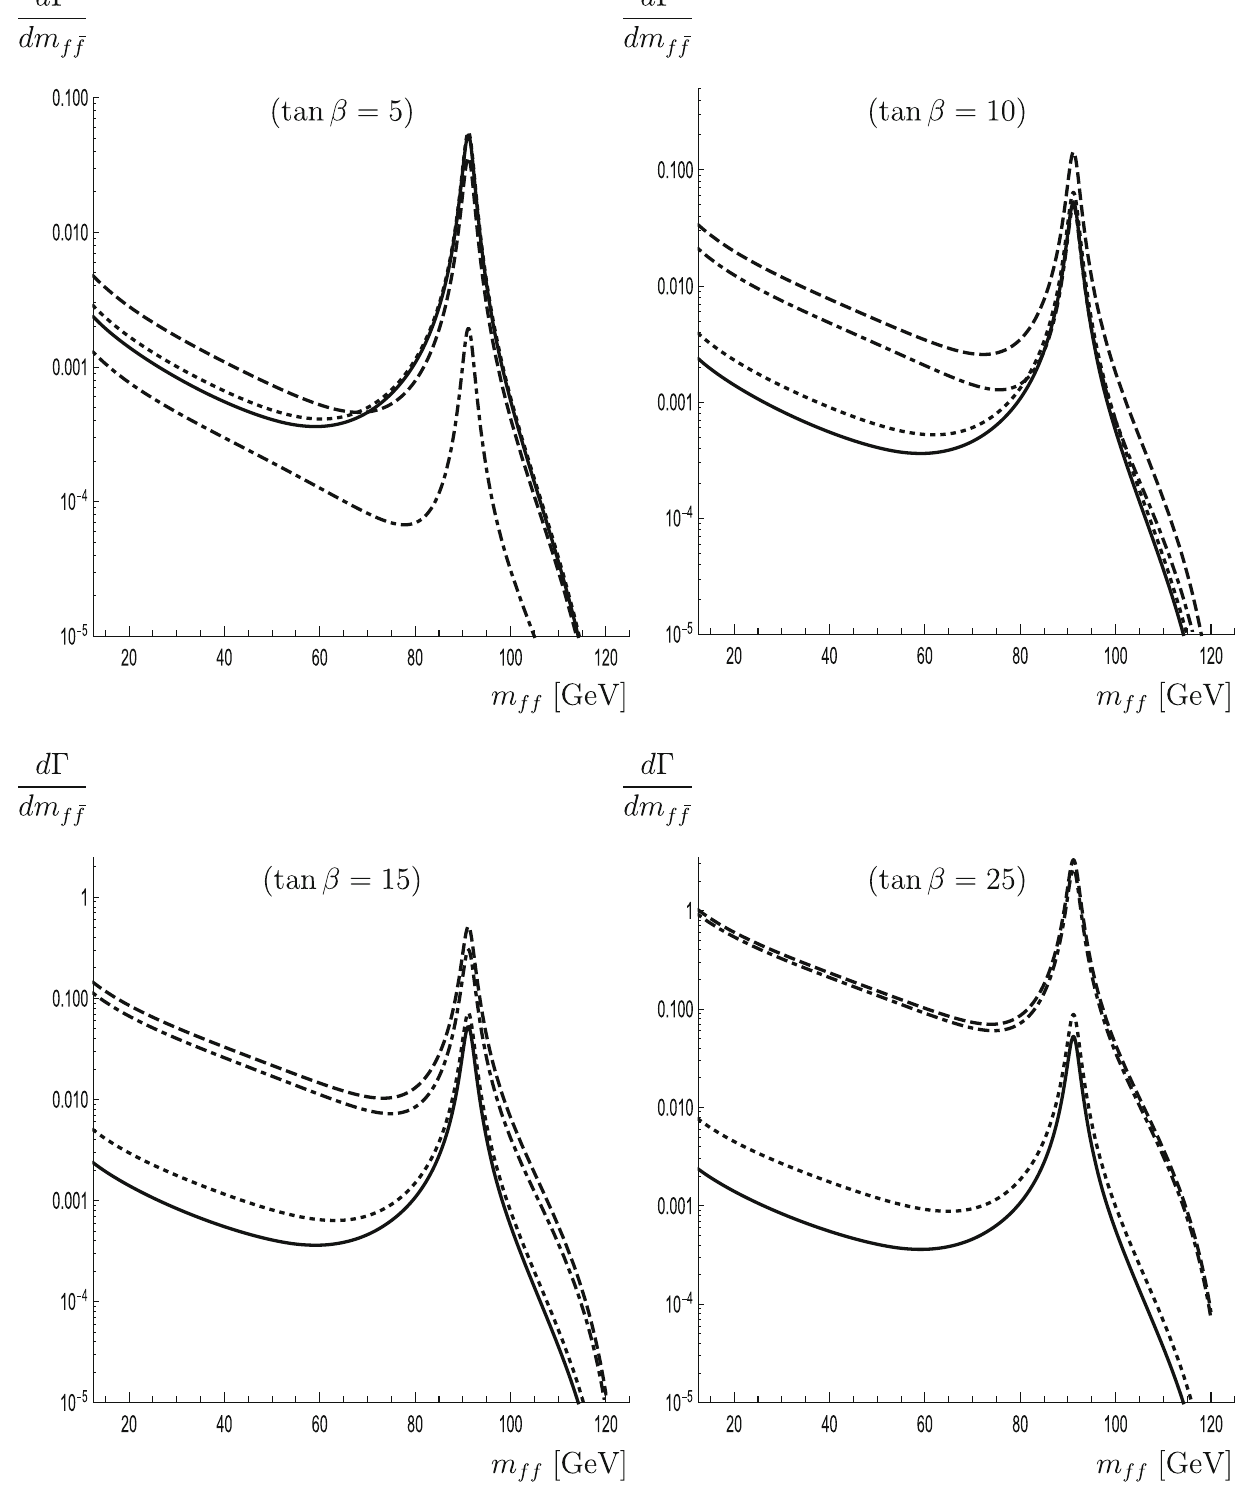
Fig. 16 Differential decay rates as a function of the invariant mass of leptons m f f with changing α = − 0 . 4 π, 0 , 0 . 4